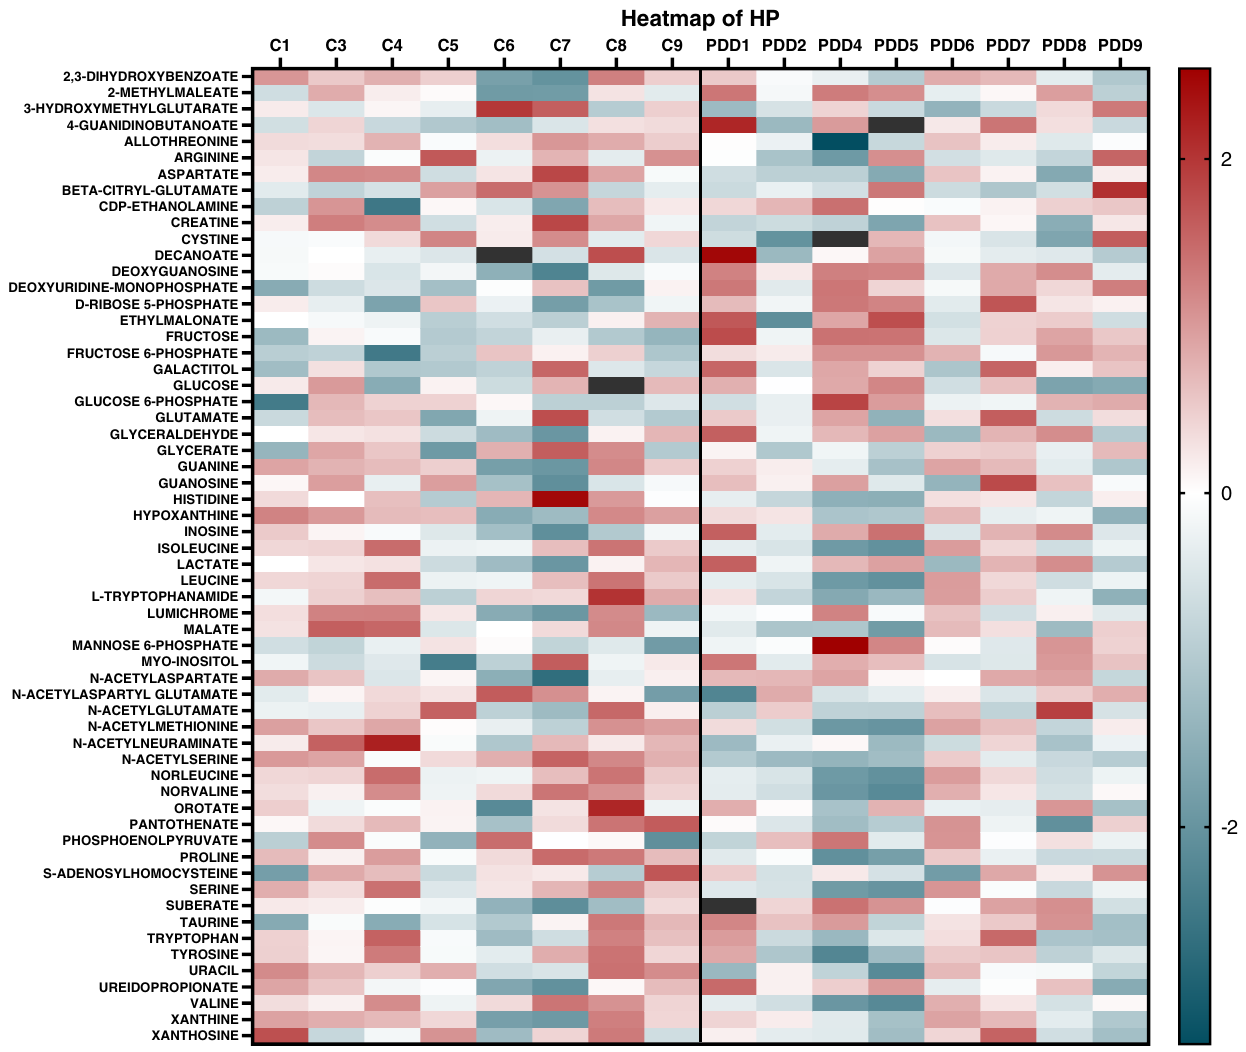
Fig. 2 Heat map of metabolites in HP of PDD case and control brains. Heat map created using z -score normalised data in GraphPad Prism v9.1.2. All identi fi ed metabolites are shown. The darker the colour, the greater the difference in concentration relative to the mean; the red colour denotes increased relative concentrations; the blue colour denotes decreased relative concentrations. Black rectangles denote excluded values. C control, PDD Parkinson ’ s disease dementia